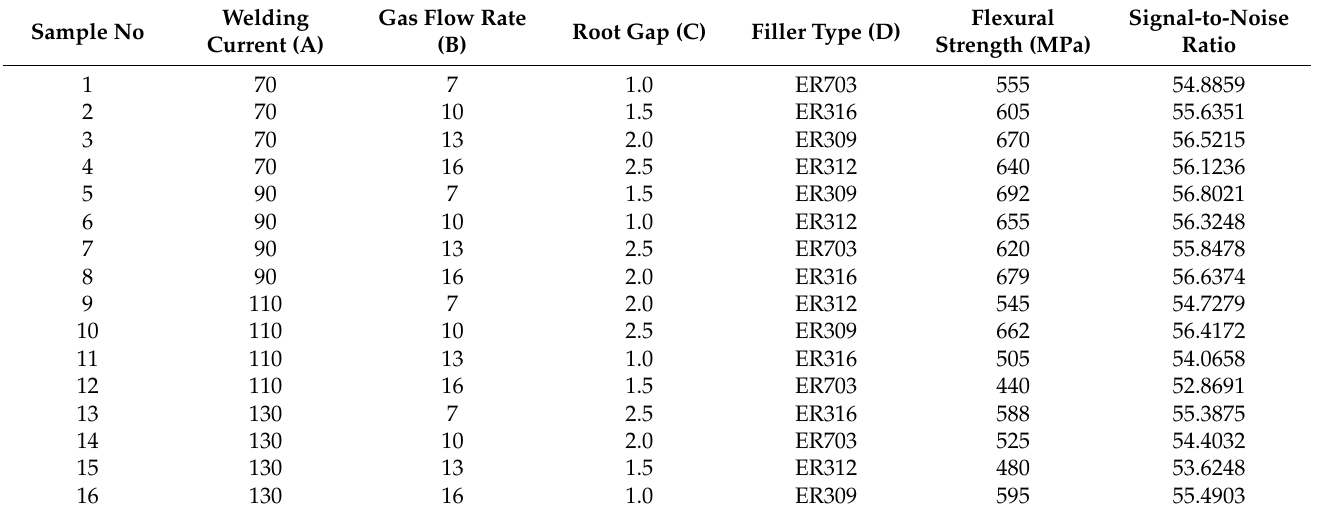
Table 15. Flexural strength test result.